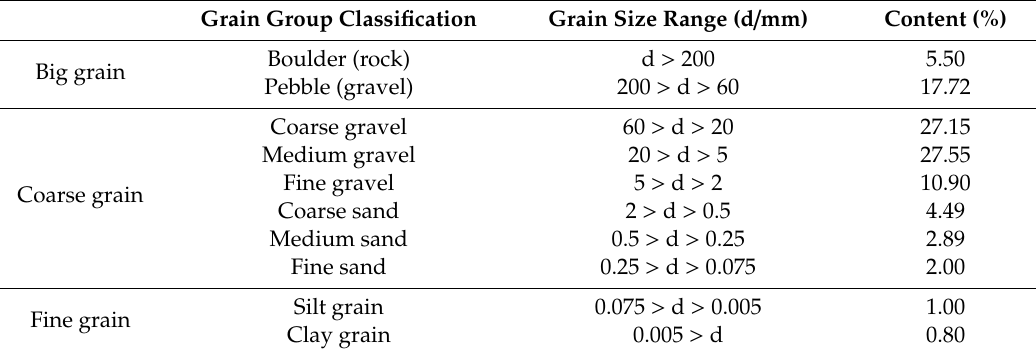
Table 1. Content of each grade of grains in the dump